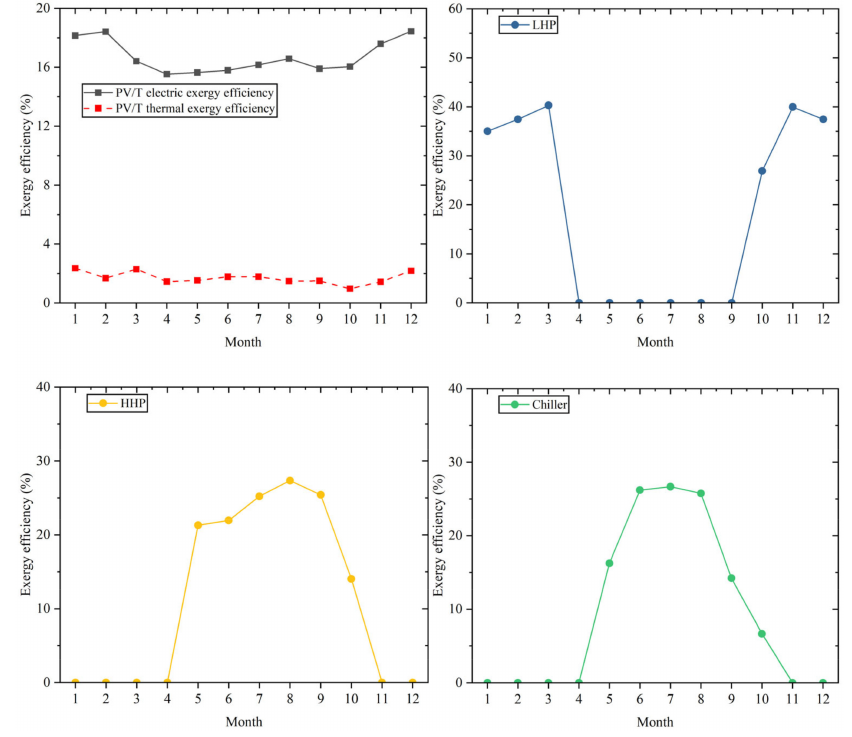
Figure 14. Exergy efficiency of each